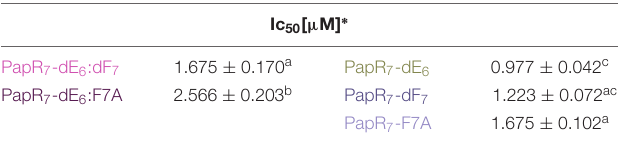
TABLE 1 | Comparison between IC 50 values of new PapR 7 -derived peptide combinations and their parent inhibitors, as determined by the lacZ -based reporter assay.